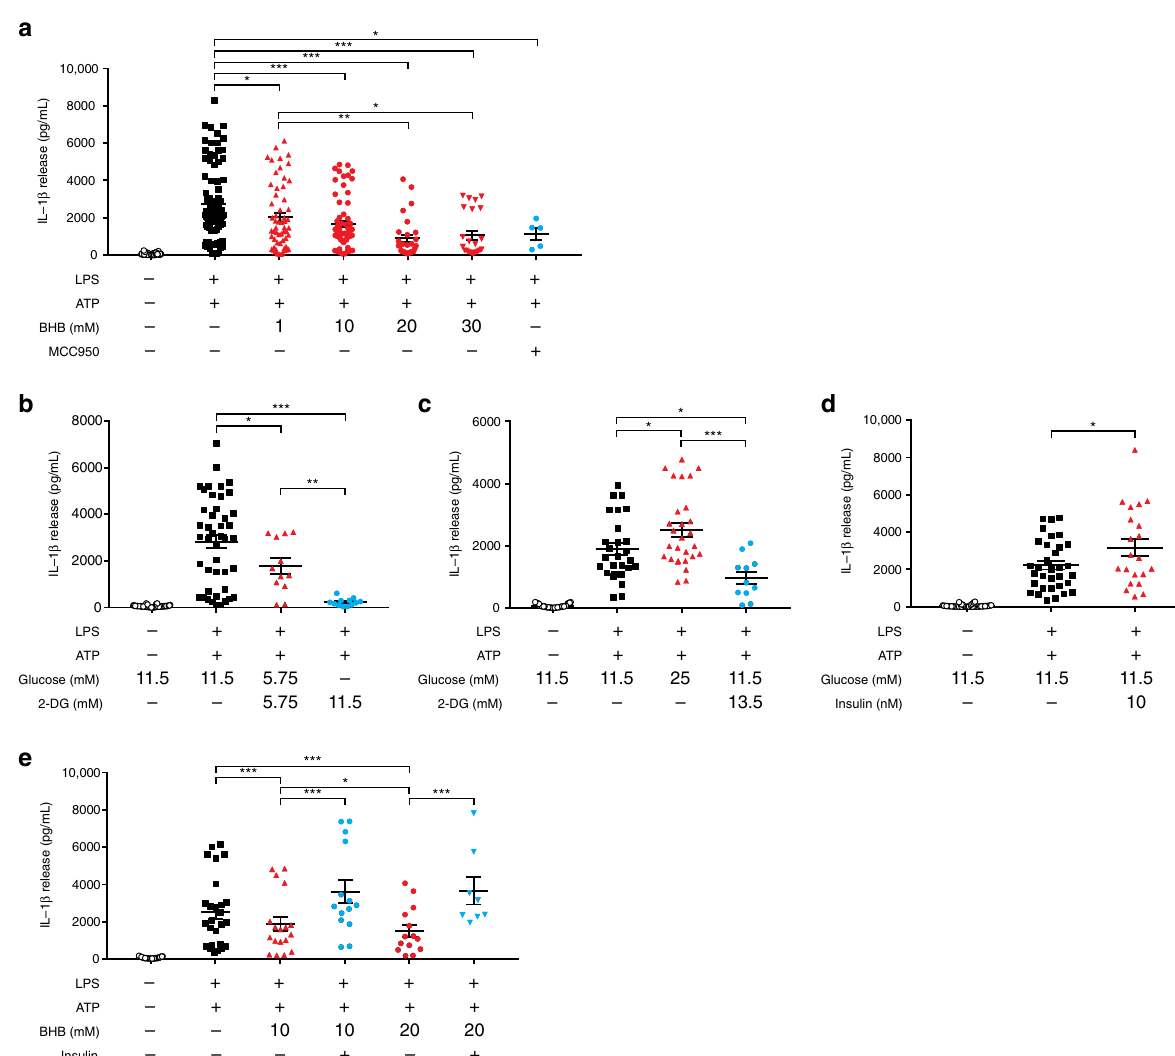
Fig. 4 Effects of BHB, glucose, and insulin on NLRP3 in fl ammasome activation in human macrophages by ELISA assay. IL-1 β secretion when exposed to vehicle or 2 mM ATP with 0.1 μ g/mL LPS priming and increased BHB (1, 10, 20, and 30 mM) or 100 nM MCC950, a small-molecule inhibitor of NLRP3 in fl ammasome (administered for the last 5 hours as a positive control) ( a ); increased 2-DG ( b ); increased glucose (11.5 mM vs. 25 mM) ( c ); 11.5 mM glucose with/without 10 nM insulin ( d ); increased BHB (10 mM vs. 20 mM) with/without 10 nM insulin ( e ). 5 – 64 biologically independent samples per treatment; experiments on each treatment were repeated up to three times per sample. Symbols are data points from independent experiments: n = 137, 90, 58, 64, 28, 24, 5 ( a , left to right), 66, 44, 12, 12 ( b , left to right), 39, 27, 28, 11 ( c , left to right), 48, 33, 21 ( d , left to right), 39, 26, 18, 14, 14, 8 ( e , left to right). Data are represented as mean ± SEM. One-way analysis of variance (ANOVA) using Tukey ’ s test or a two-tailed Student ’ s t test with the Bonferroni method for adjusting P values; * P < 0.05, ** P < 0.01, and *** P < 0.001. BHB β -hydroxybutyrate, IL-1 β interleukin-1 β , NLRP3 NLR family, pyrin